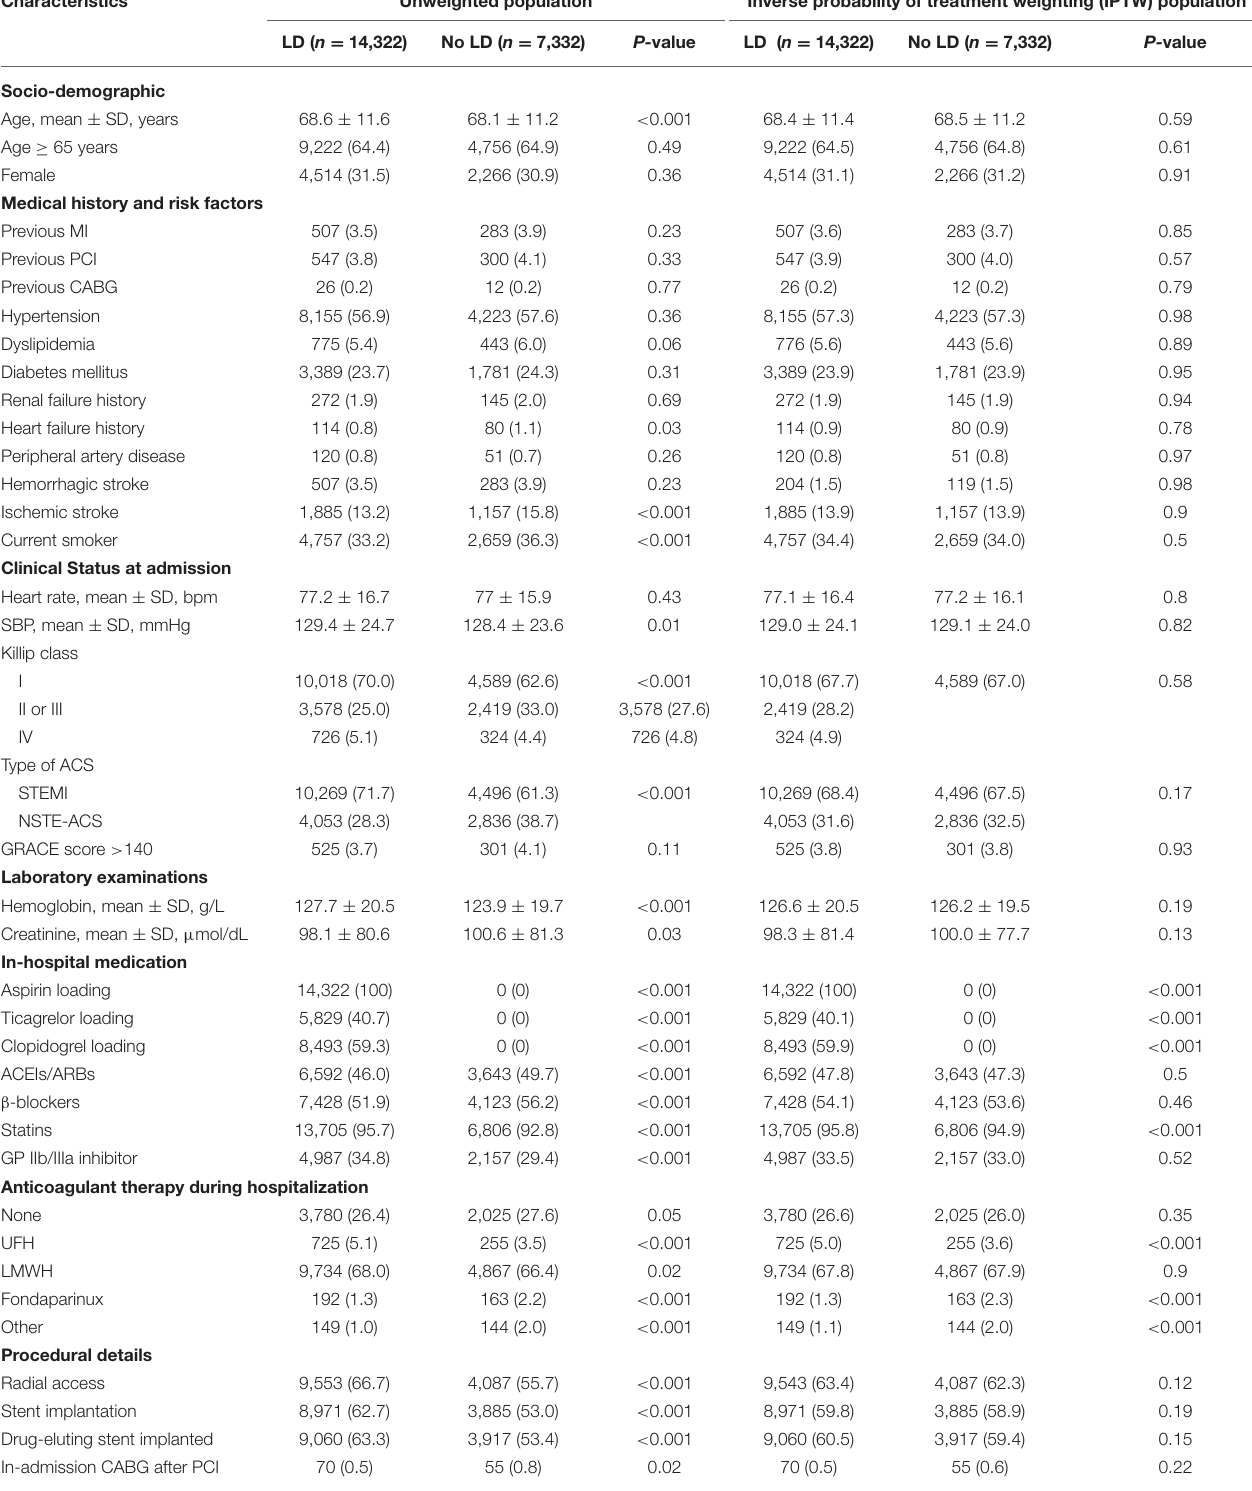
TABLE 1 | Baseline